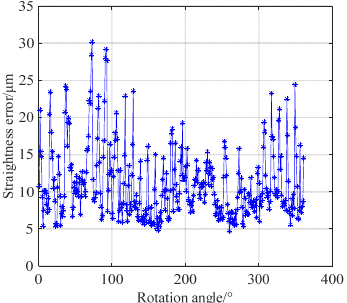
Figure 18. Graph of 360 straightness deviation results.